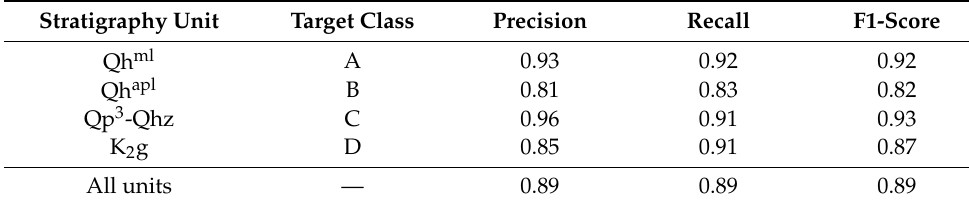
Table 2. The testing results of the stratigraphic classification. Stratigraphy Unit